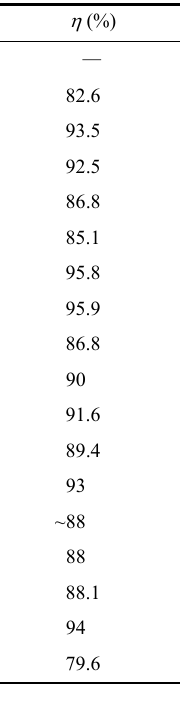
Fig. 7 (a) Al, Mn, and Ti element distribution in the BaTiO 3 -based ceramics with Al 2 O 3 coating. (b) Energy-storage properties of the BaTiO 3 -based ceramics without and with an Al 2 O 3 coating. Reproduced with permission from Ref. [40], © The American Ceramic Society 2017. Table 2 Energy-storage properties of BT-based bulk